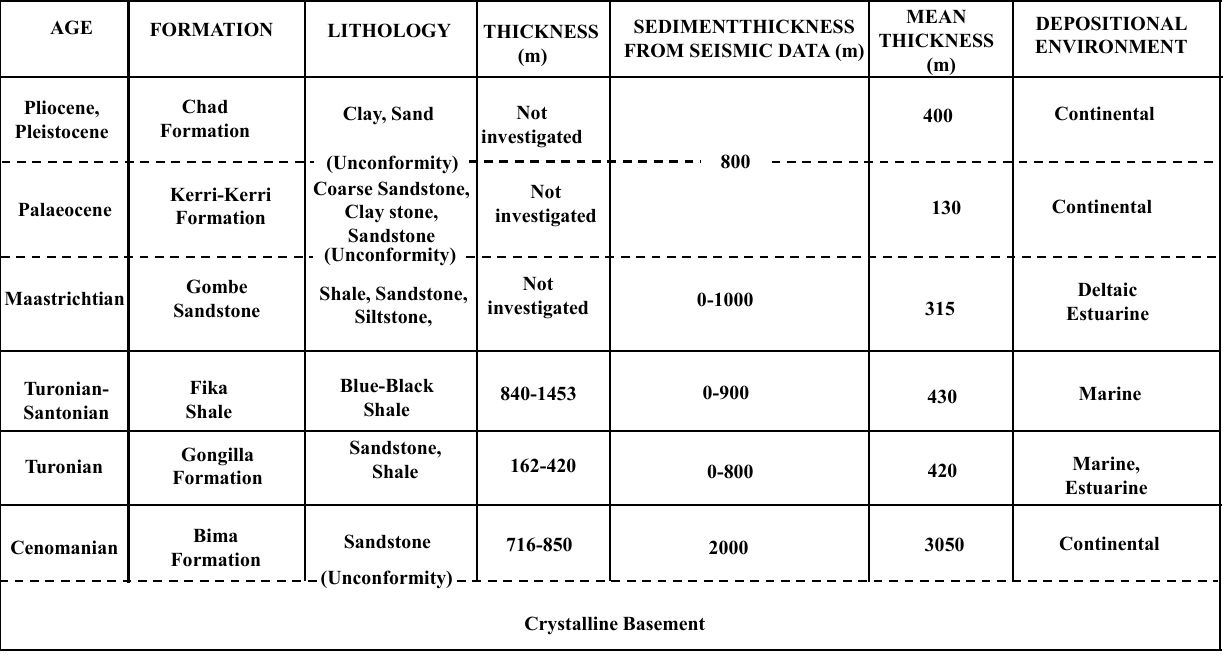
Figure 2. The stratigraphic succession, average thicknesses of formations and thicknesses recorded in the studied wells in the Nigerian sector of the Chad Basin [47,57].